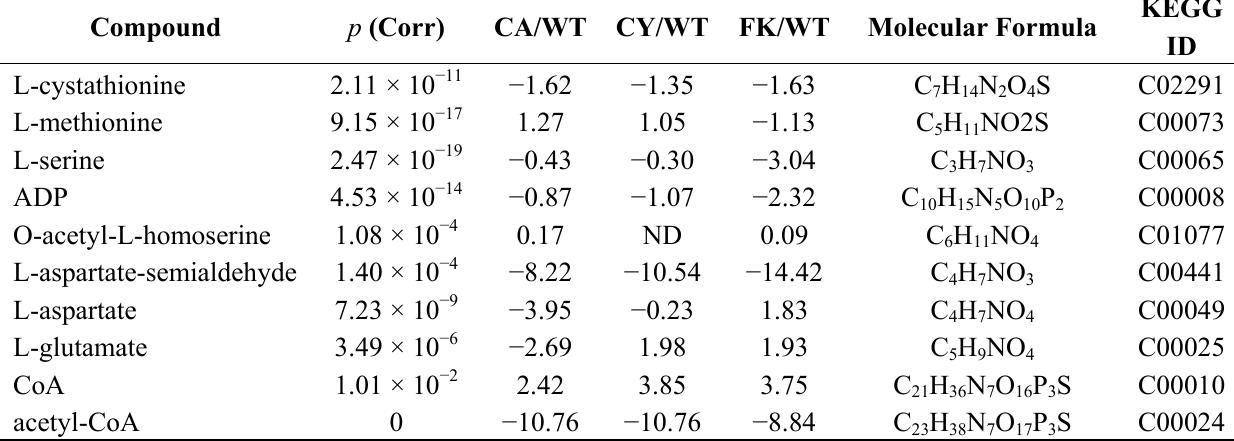
Table 1. Metabolites enriched to the sulfur amino acid biosynthesis